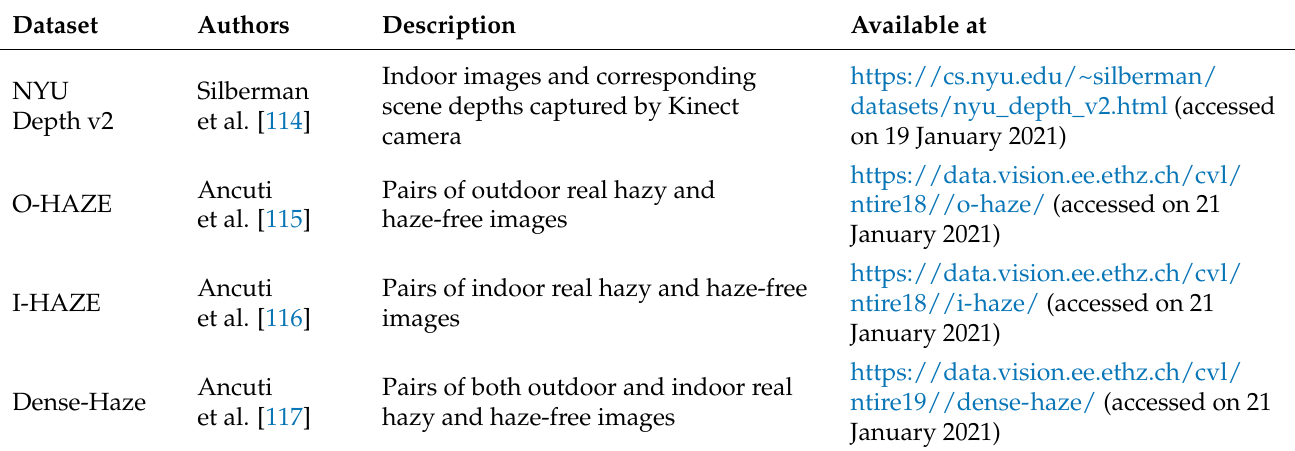
Figure 14. Typical procedure for preparing the synthetic training dataset. Table 3. Summary of usable training datasets mentioned in this